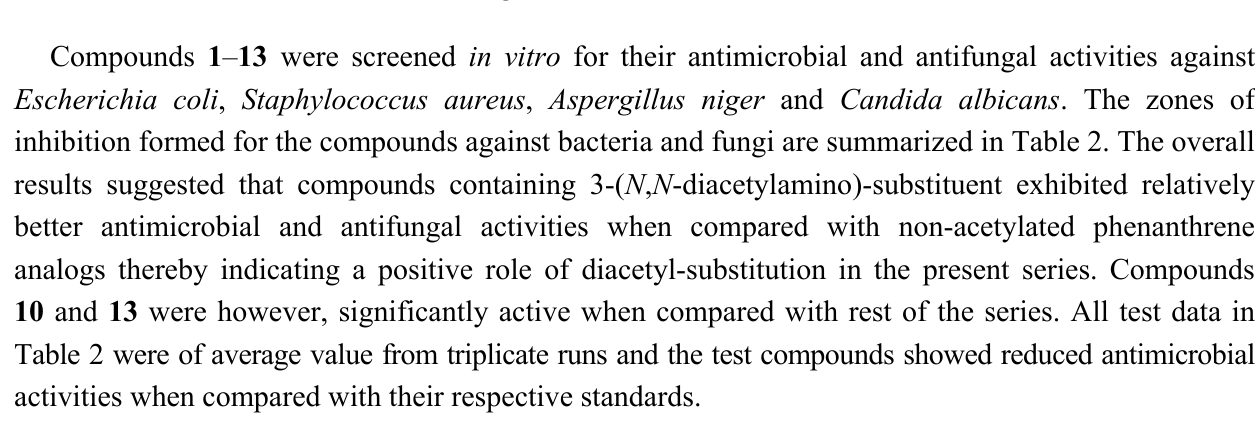
Table 2. Anti-bacterial and anti-fungal data of compounds 1 – 13